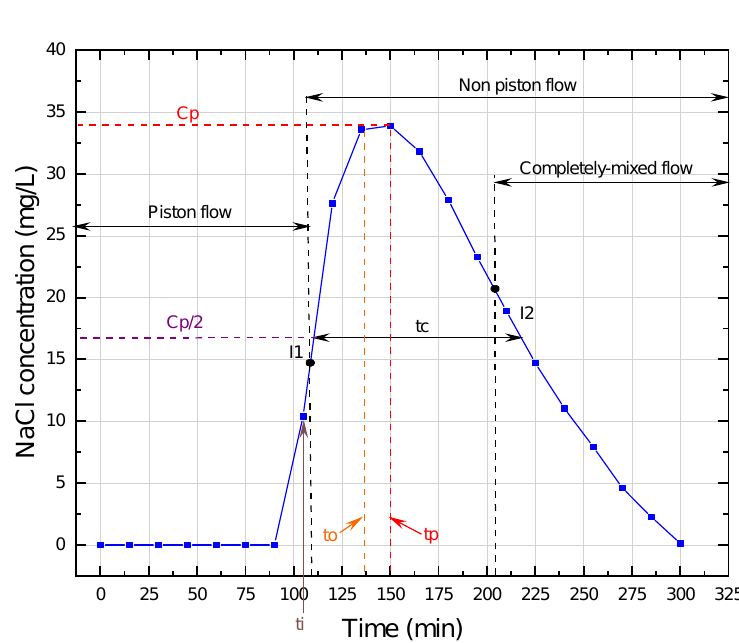
Figure 3. Variation of tracer concentration in the effluent of the UGFL–Flow 0.5 m 3 /d.